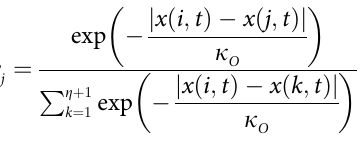
P Z þ 1 ¼ 1 w j j ¼ 1